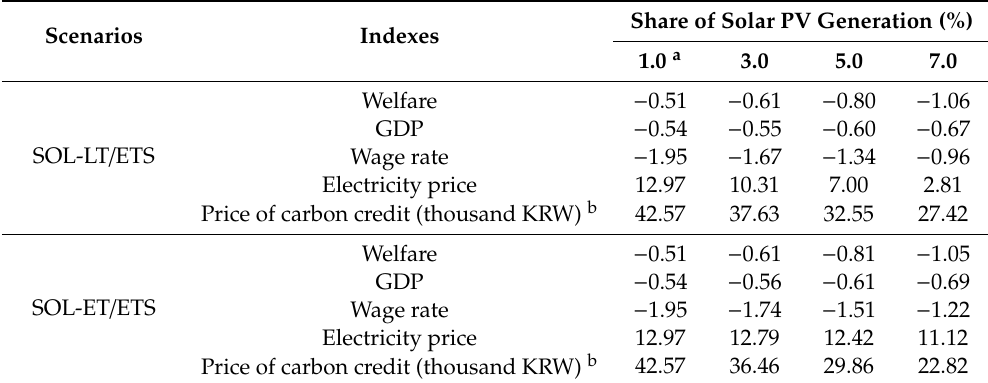
Table 12. Macroeconomic e ff ects of solar PV generation expansion with emission regulations (% changes from the base